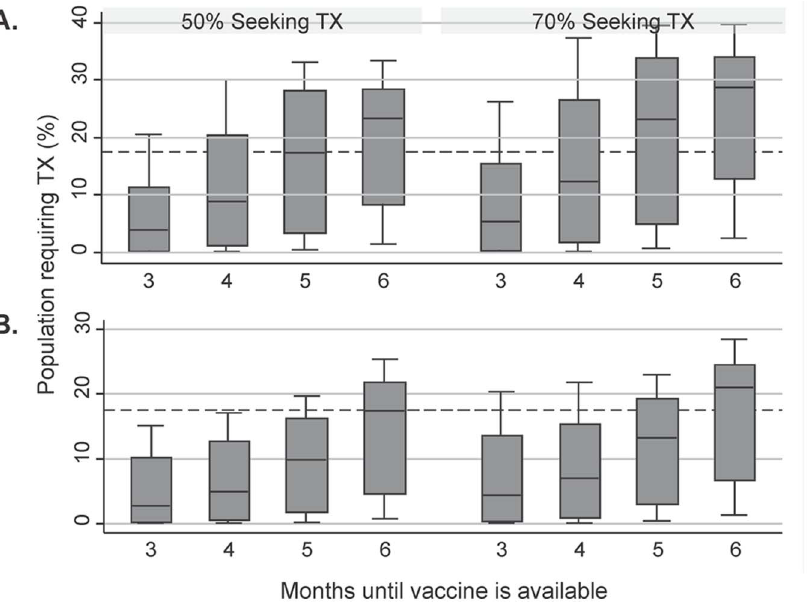
Figure 1. Projected range of treatment required for different pandemic wave patterns. The median (line within the shaded box), 25 th and 75 th percentile values (top and bottom of shaded box), and upper and lower adjacent values (error bars) proportion of the Canadian population expected to require antiviral treatment (Y-axis) in the presence of a safe and effective pandemic vaccine that becomes available at different points in time (X-axis). We assumed that the proportion of clinical cases seeking medical attention for their illness was 50% (left) or 70% (right). The dashed line represents the proportion of the Canadian population who would be able to be treated by our existing stockpile (17.5%). A – Fall/Winter emergence, 1 wave; B – Spring emergence, 2 waves.